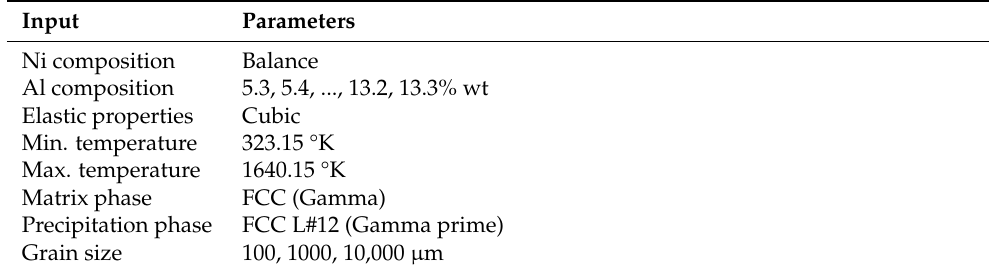
Table 2. Parameters used for the simulation of TTT diagrams in the software Thermo-Calc™ .